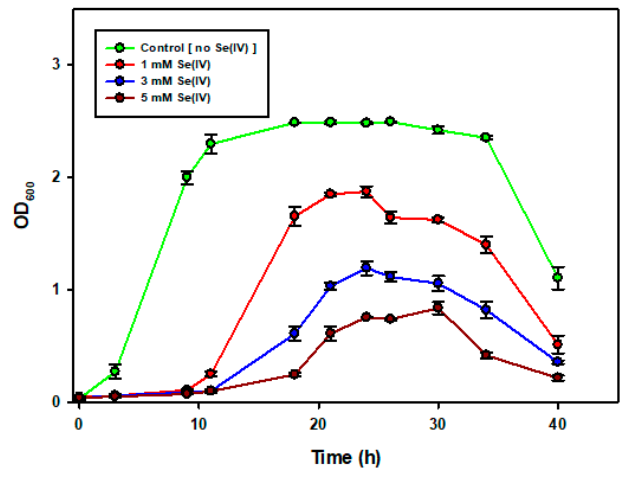
Figure 1. The effect of increasing selenite concentration on bacterial growth.